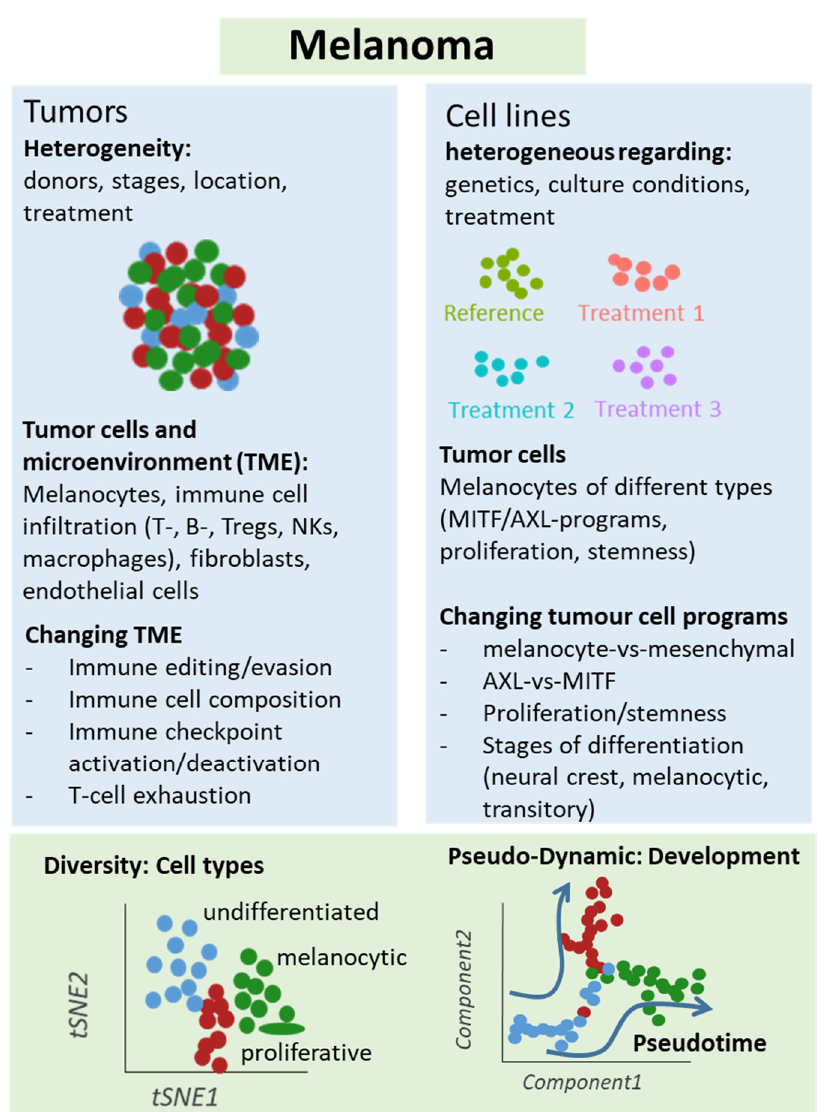
Figure 2. Schematic representation of single-cell analyses in melanoma samples. Either melanoma tumors or cell lines underwent single-cell sequencing analyses, which unraveled different types of cells and levels of heterogeneity in melanoma lesions and mechanisms of treatment resistance, e.g., mediated by T cell exclusion or T cell exhaustion programs under immune checkpoint therapy. Changes in cellular programs in tumor cells were also identified in cell culture studies supporting a role of the dichotomy of the AXL and MITF programs for treatment response and